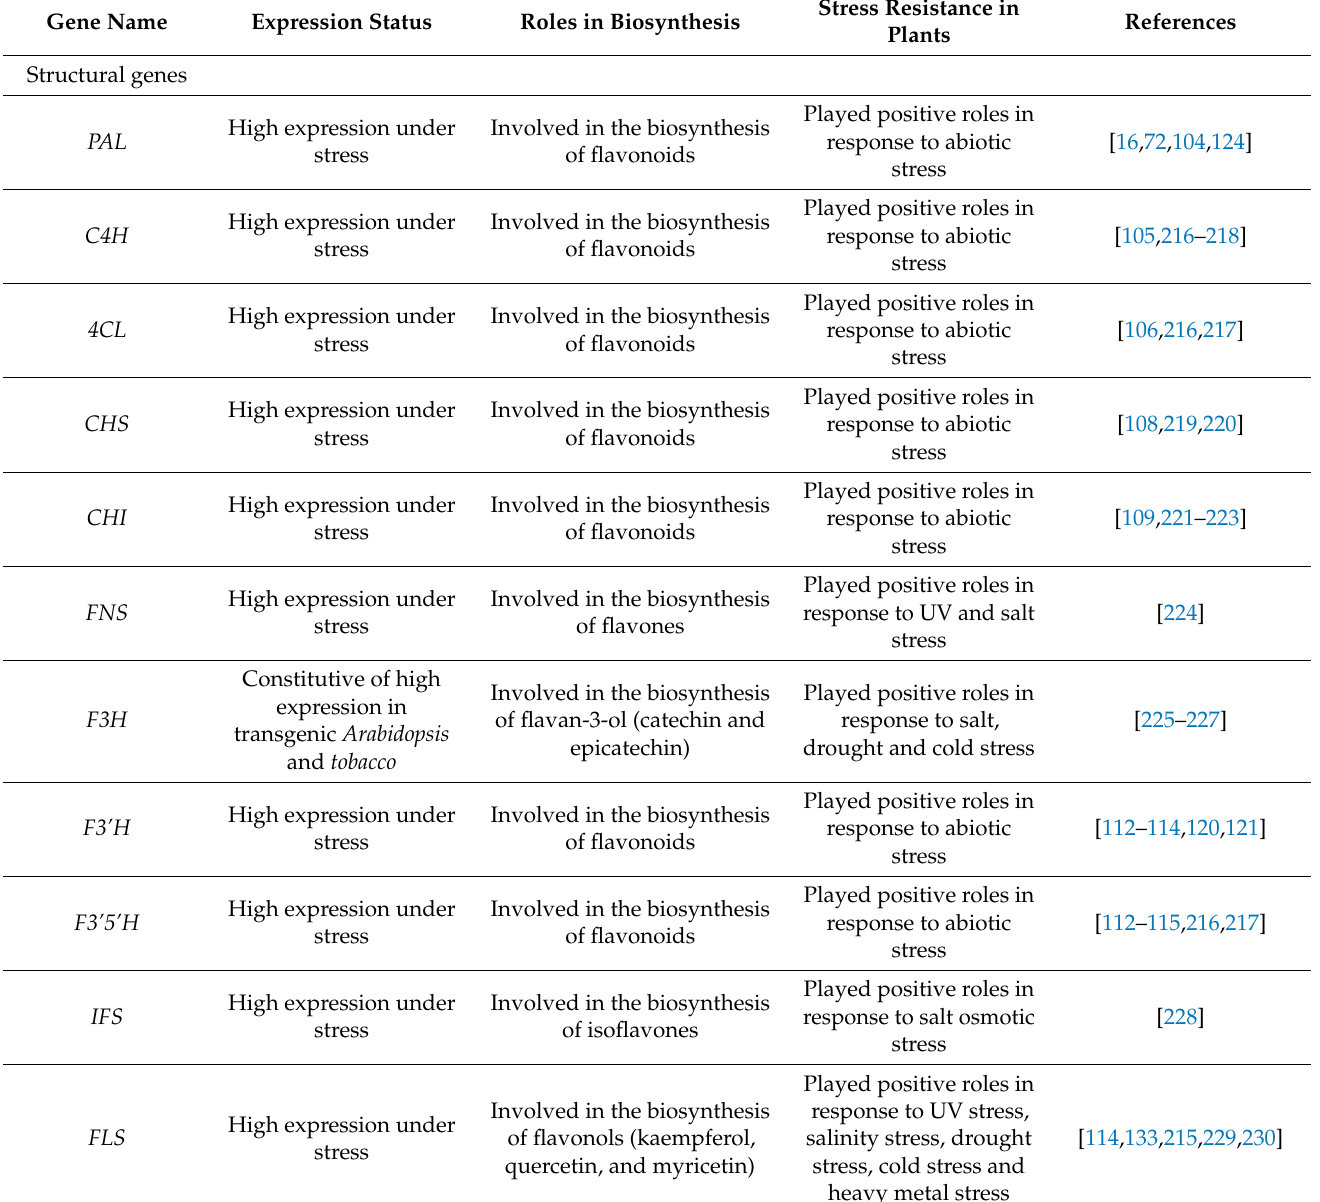
Table 1. The roles of genes involved in flavonoid biosynthesis and the response of plants to various biotic and abiotic